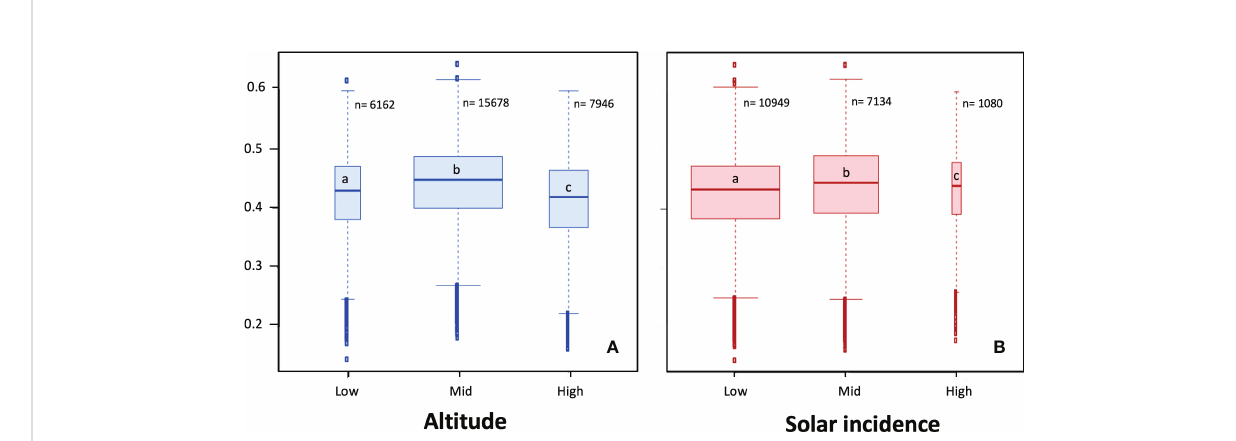
FIGURE 4 NDVI of altitudinal bands (A) and solar incidence value ranges (B) . Different letters indicate signi fi cant differences between altitude or solar incidence levels ( p < 0.05; Bonferroni post-hoc tests following repeated measures ANOVA; see Supplementary Table 3). N values correspond to the number of pixels for each